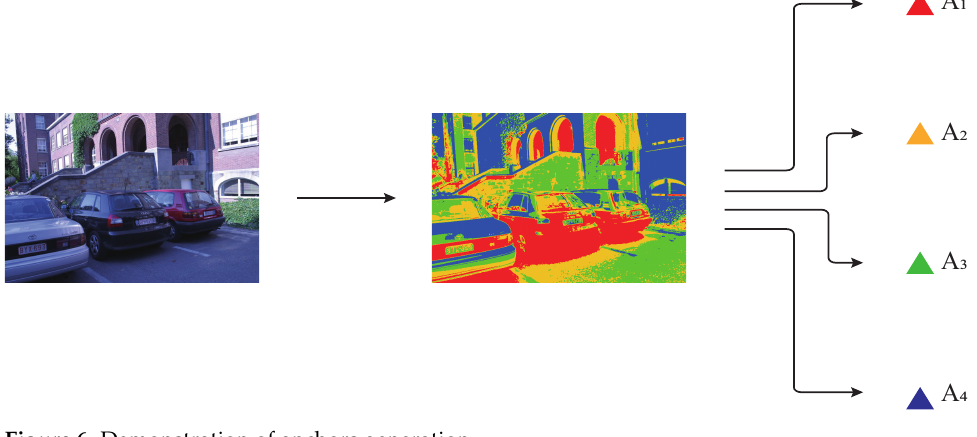
Figure 6. Demonstration of anchors